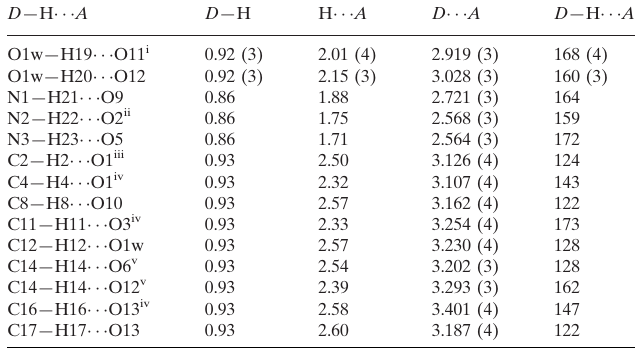
Hydrogen-bond geometry (A˚ , (cid:3)